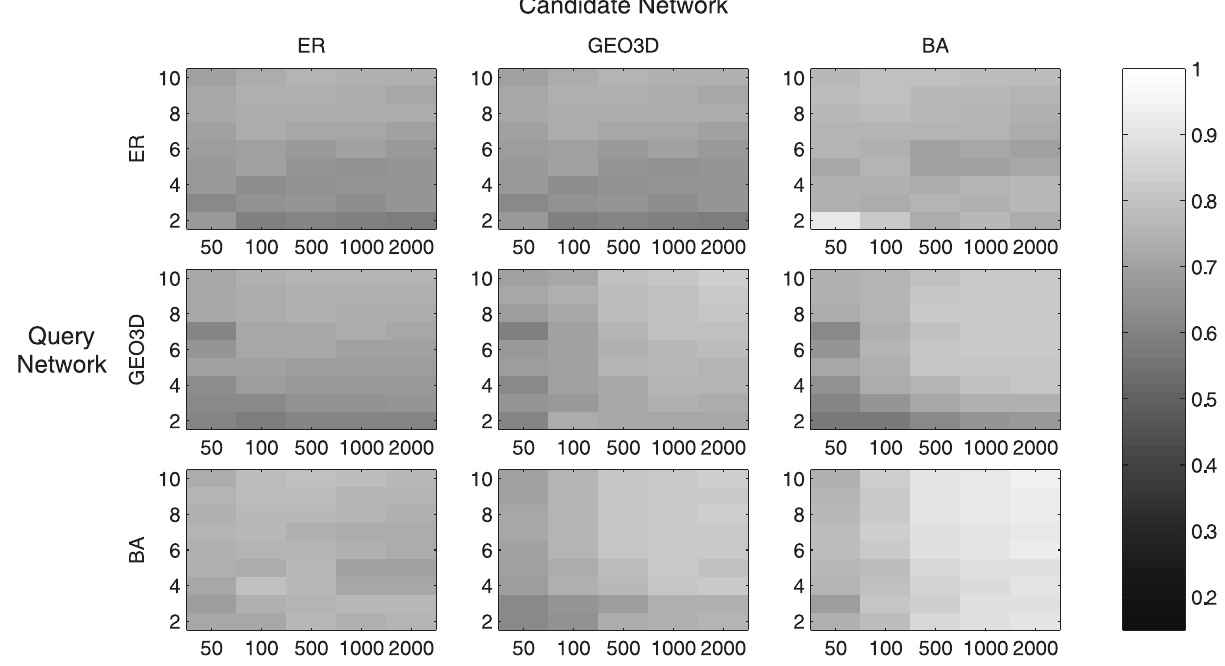
Figure 3. Heat map of average GDDA score in various comparisons. Each subplot represents the heat map of average GDDA score of a single type comparison. For instance, the bottom left subplot is the comparison of Scale-free (SF) network versus Erdos Renyi (ER) network, SF network is the Query Network and ER network is the candidate network. In each subplot, the y-axis represents the average degree, x-axis represents the network size (vertex number) the grey level represents the average.